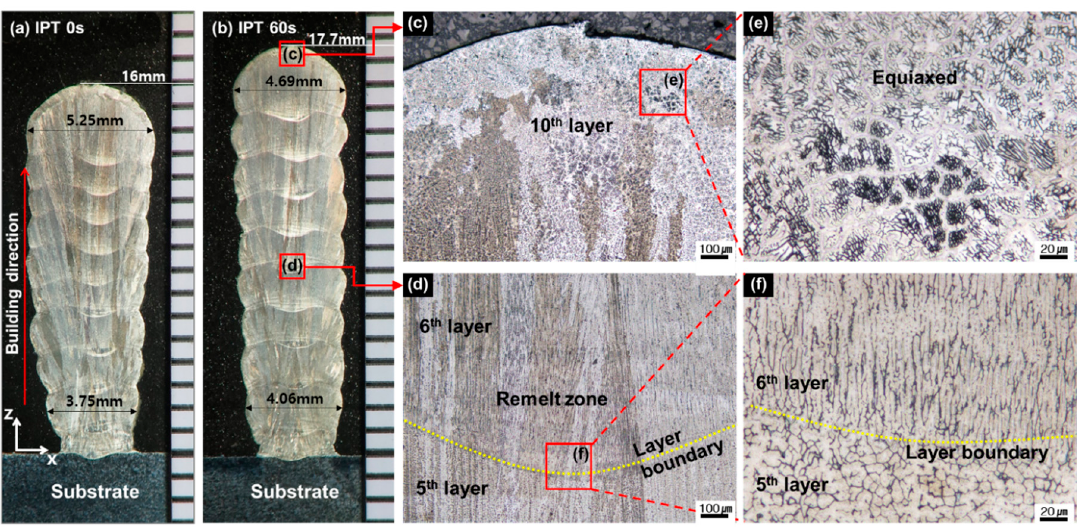
Figure 4. Macro cross-section photograph for ( a ) 0 s IPT and ( b ) 60 s IPT, ( c ) 10 th layer (surface) for 60 s IPT, ( d ) layer boundary of 60 s IPT, ( e ) the enlarged micrograph of the surface area, and ( f ) the enlarged micrograph of the boundary.